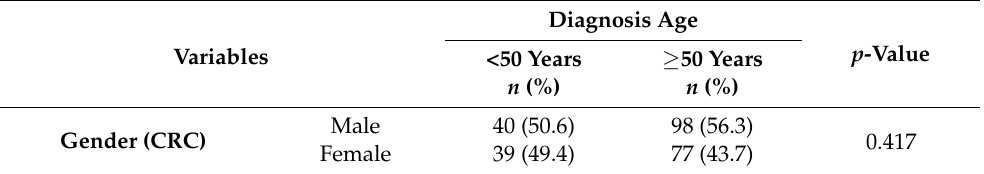
Table 2. General demographics of CRC patients stratified by